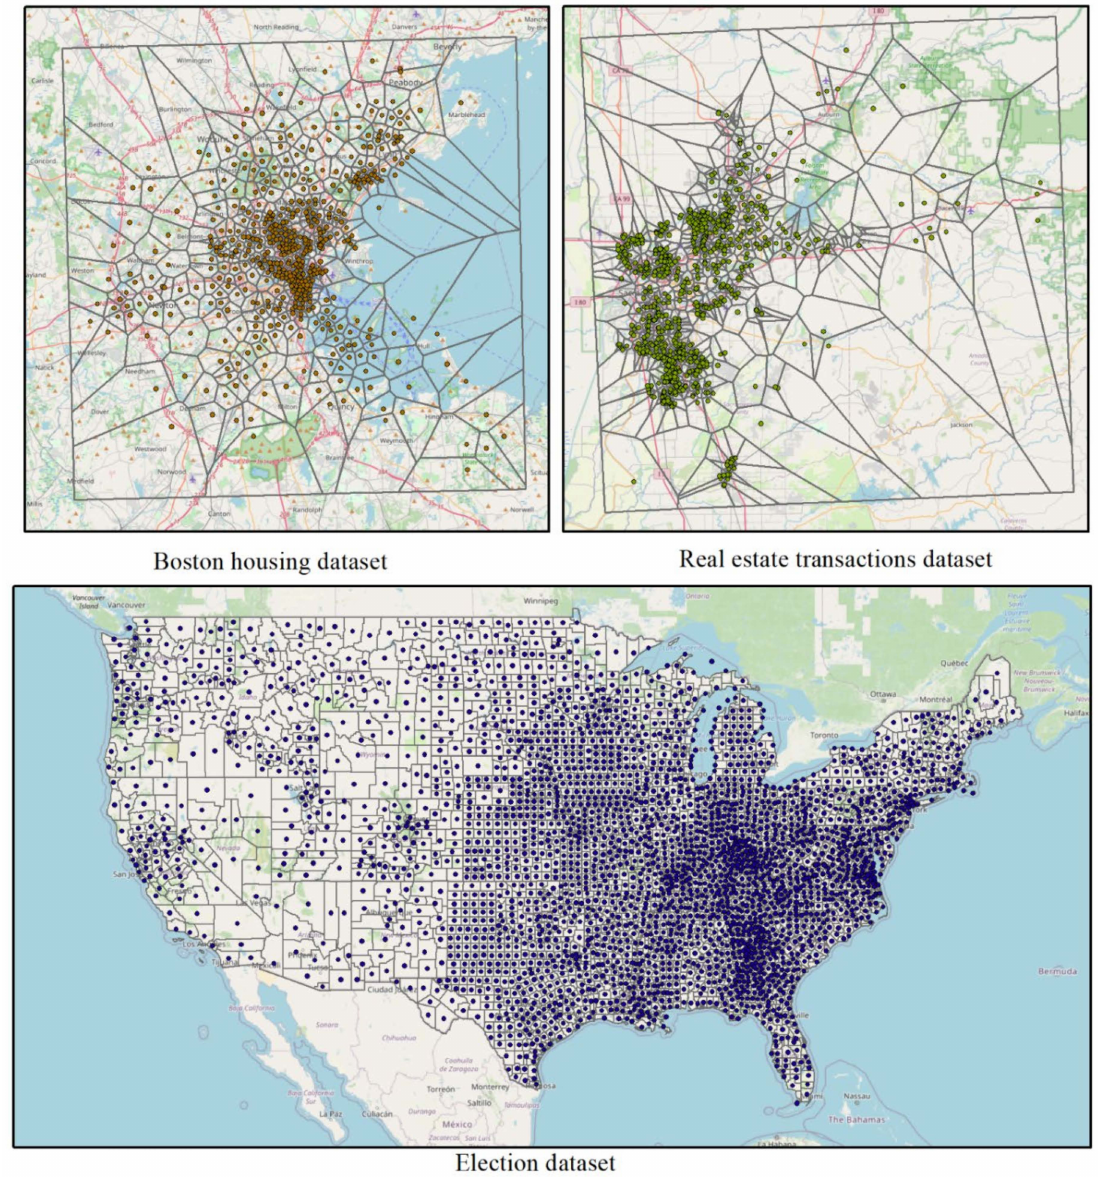
Figure 3. Data distribution of the Boston housing, real estate transactions and election datasets. Global Moran’s I values for the above three datasets with a first-order queen adjacency matrix were calculated: global Moran’s I for dependent variable medv in the Boston housing dataset was 0.584. The z-score calculated based on the random null hypothesis was 21.892. Similarly, regarding dependent variable price in the real estate transactions dataset, Global Moran’s I reached 0.551, and z reached 28.805. In terms of dependent variable vote casting ratio in the election dataset, the following values were obtained: Global Moran’s I = 0.608, and z = 58.086. The p values of these three datasets were all less than 0.0001. These indicators suggested that the spatial distribution of the dependent variables of these three datasets exhibits a significant clustering pattern, and the probability of randomly generating this clustering pattern is lower than